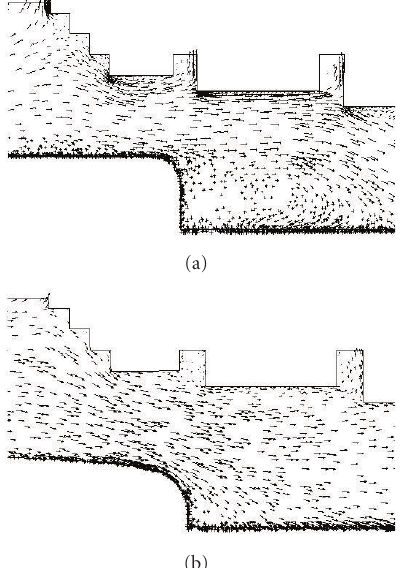
Figure 8: Flow fields at the rotor-stator gap entrance with (a) regular retaining ring, (b) spline retaining ring.